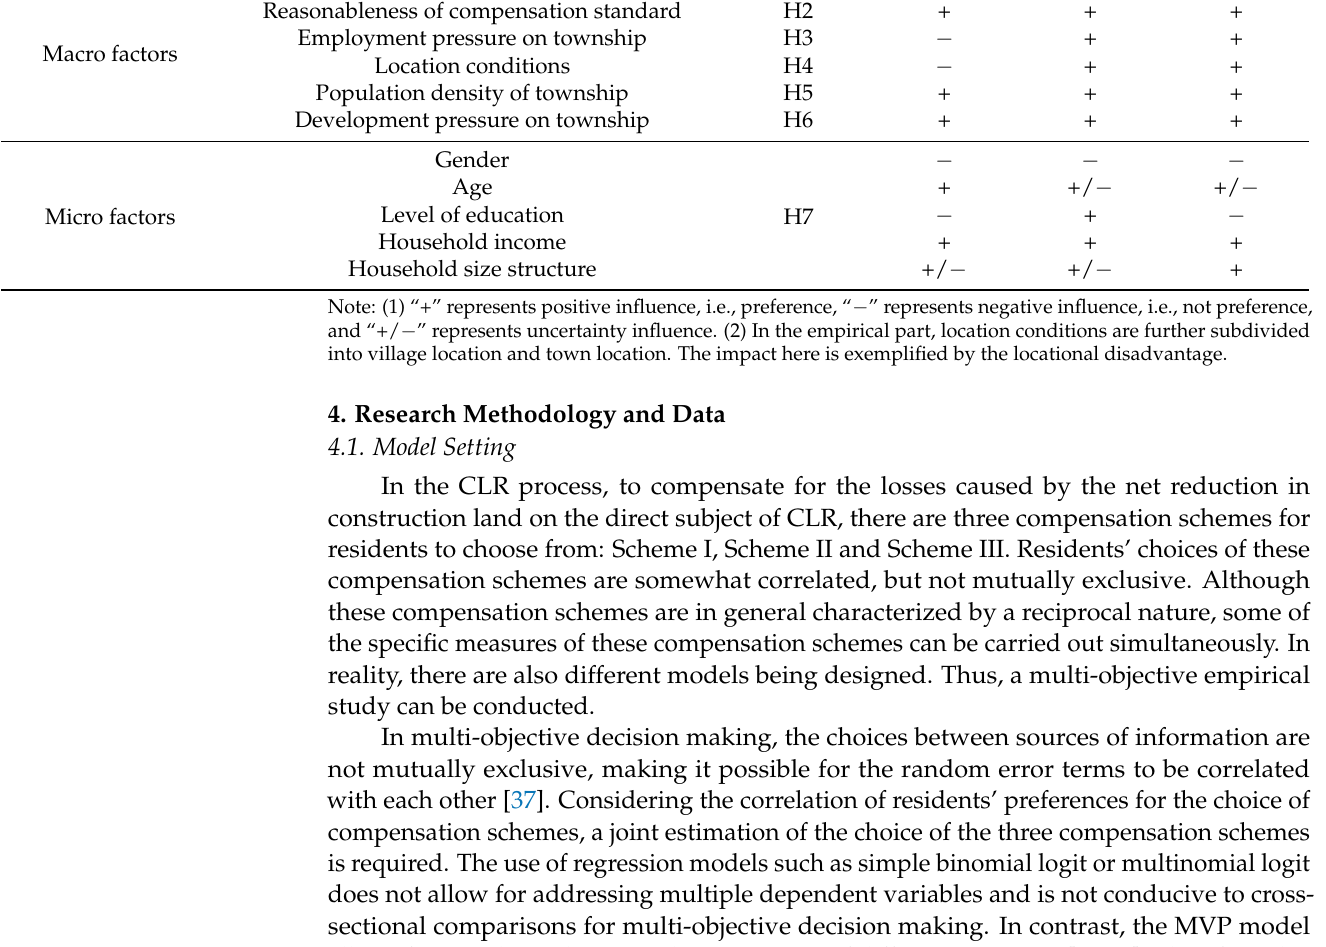
Table 2. A generalized presentation of the research hypotheses.